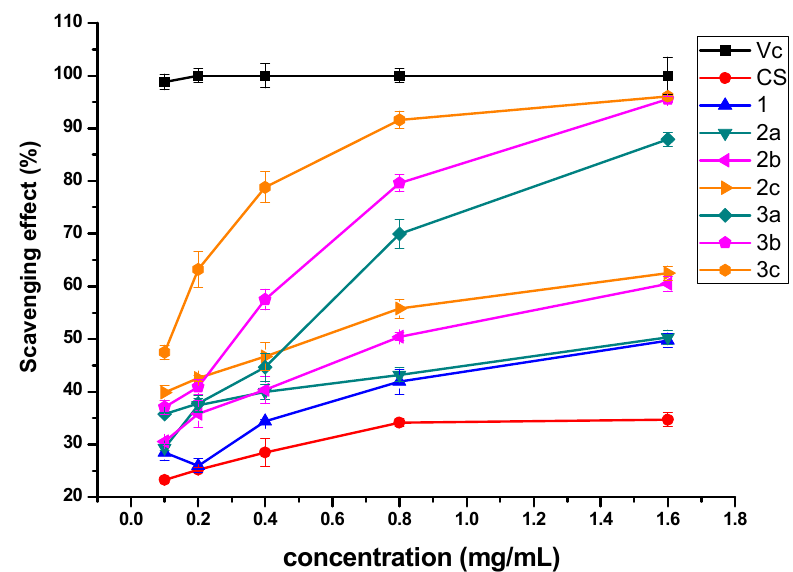
Figure 5. Superoxide-radical scavenging activity of chitosan and chitosan derivatives.